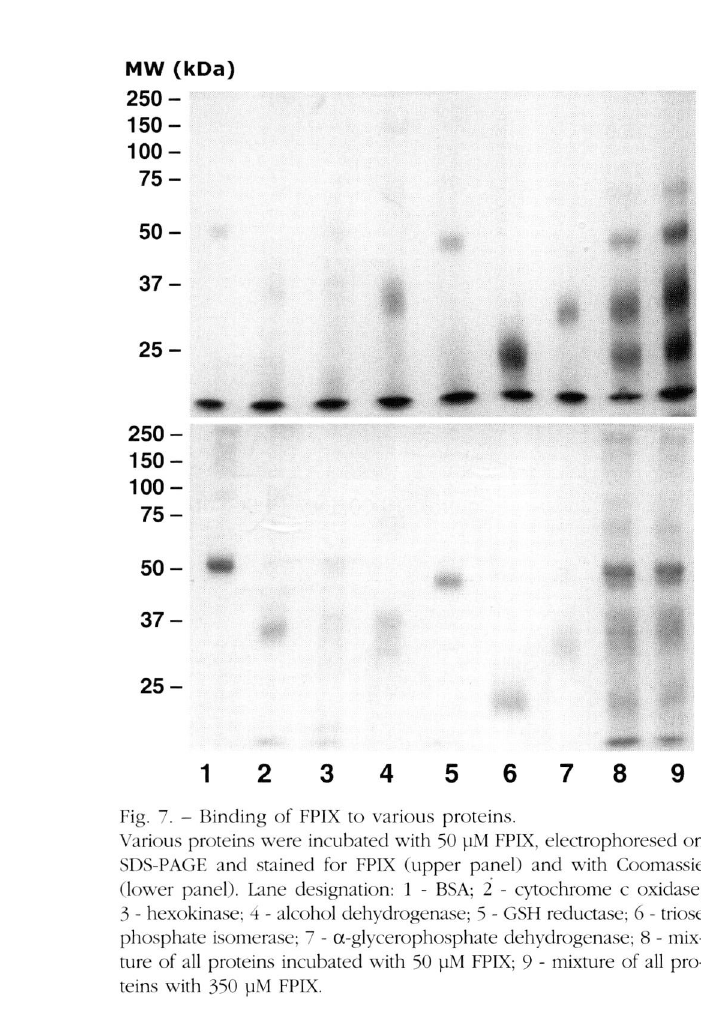
Fig. 7. - Binding of FPIX to various proteins. Various proteins were incubated with 50 µM FPIX, electrophoresed on SDS-PAGE and stained for FPIX (upper panel) and with Coomassie (lower panel). Lane designation: 1 - BSA; 2 - cytochrome c oxidase; 3 - hexokinase; 4 - alcohol dehydrogenase; 5 - GSH reductase; 6 - triose phosphate isomerase; 7 - a -glycerophosphate dehytlrogena.se; 8 - mix­ ture of all proteins incubated with 50 uM FPIX; 9 - mixture of all pro­ teins with 350 uM